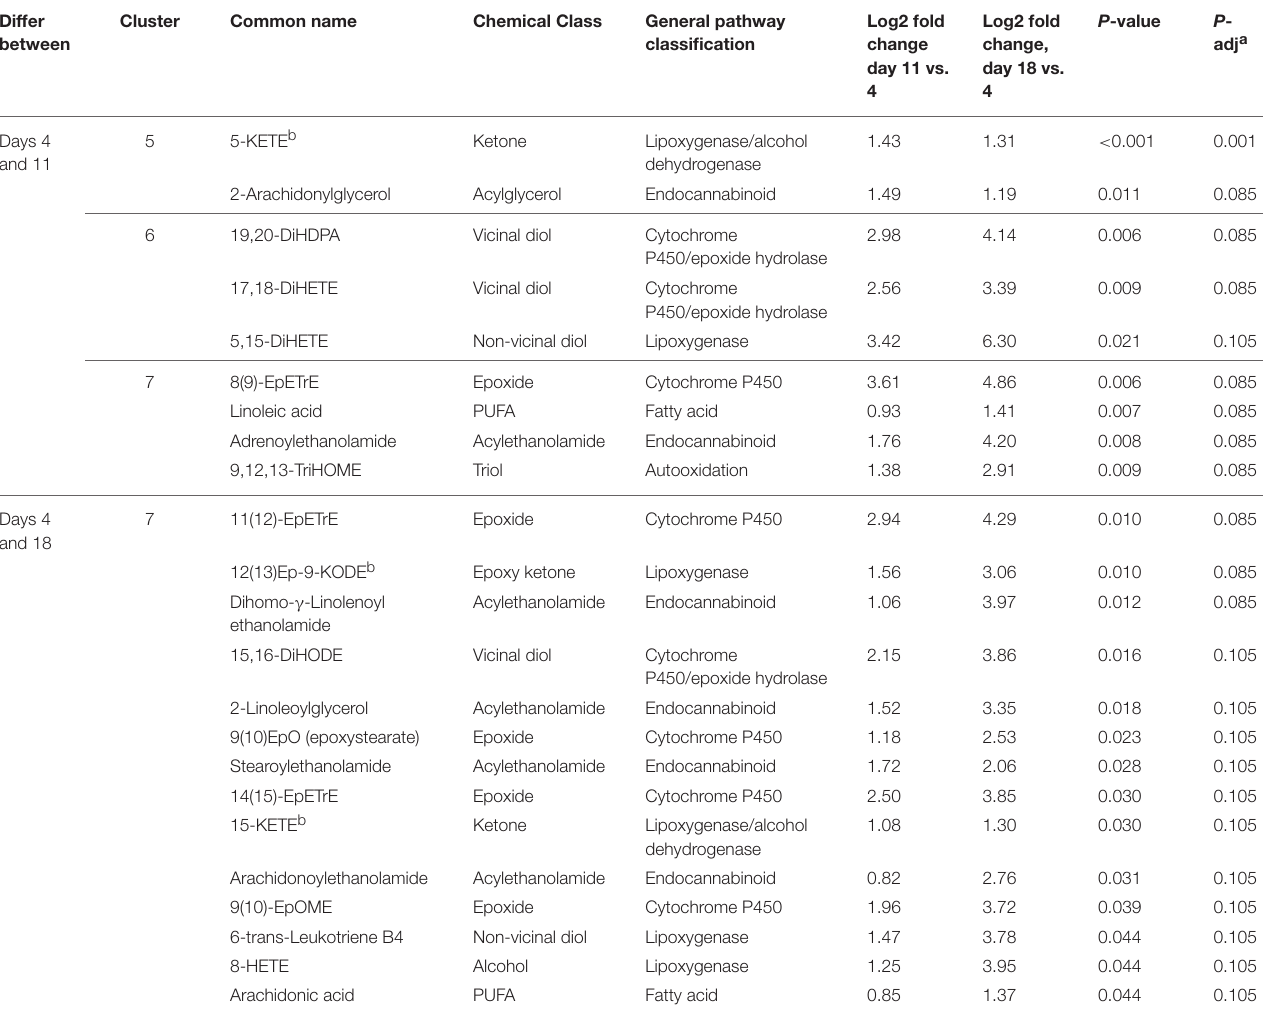
TABLE 1 | Differentially abundant lipids from CL of days 4, 11, and 18 of the estrous cycle. Differ Cluster Common name Chemical between